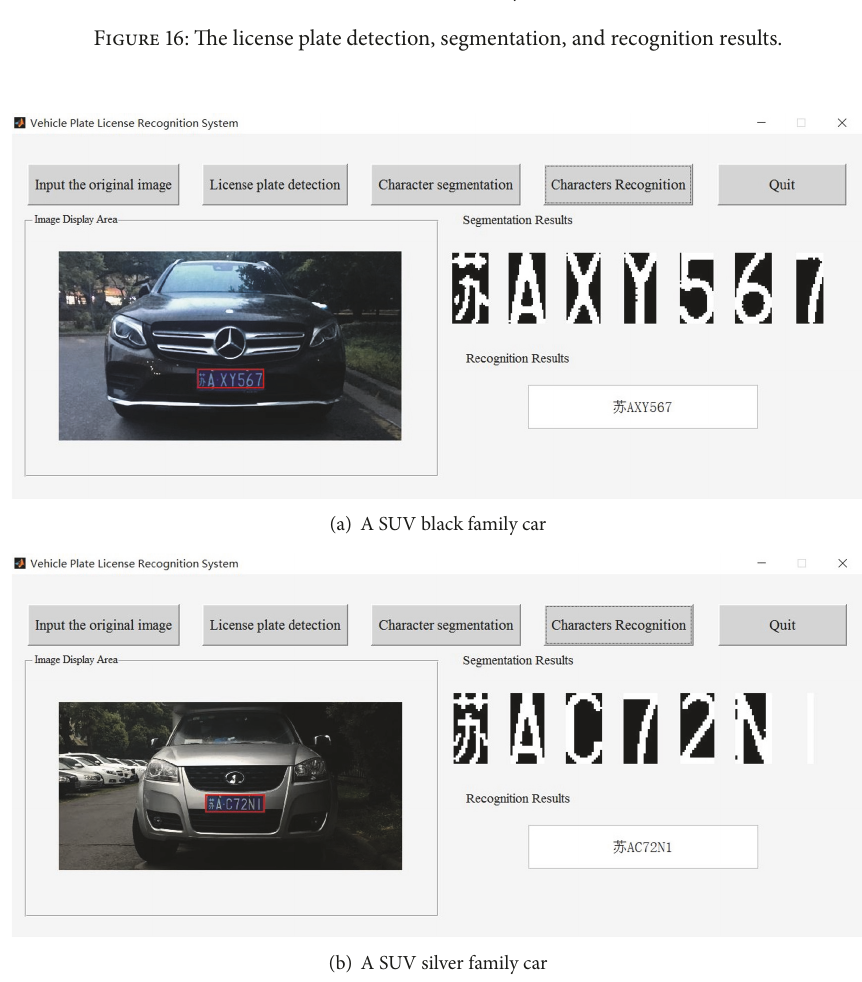
Figure 17: Recognition results of the license plate in weak illumination